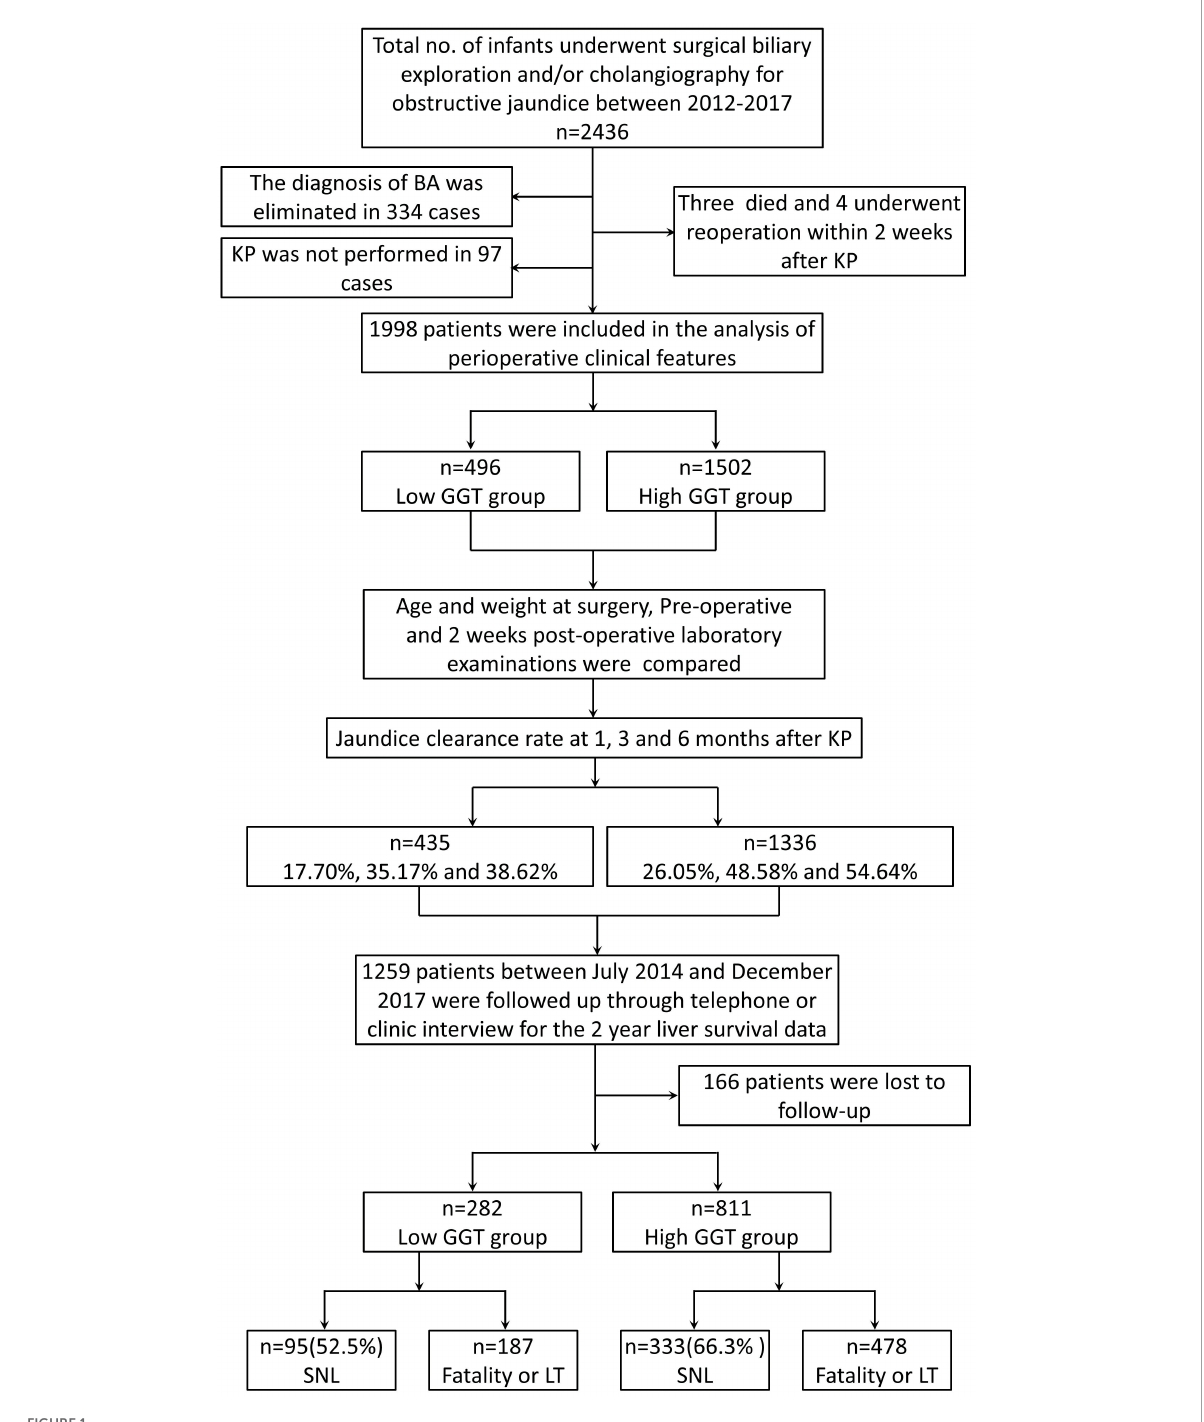
FIGURE1 Flowchart showing the study population and their outcomes. BA, biliary atresia; KP, Kasai procedure; GGT, gamma-glutamyl transpeptidase; SNL, survival with native liver; LT, liver transplantation.